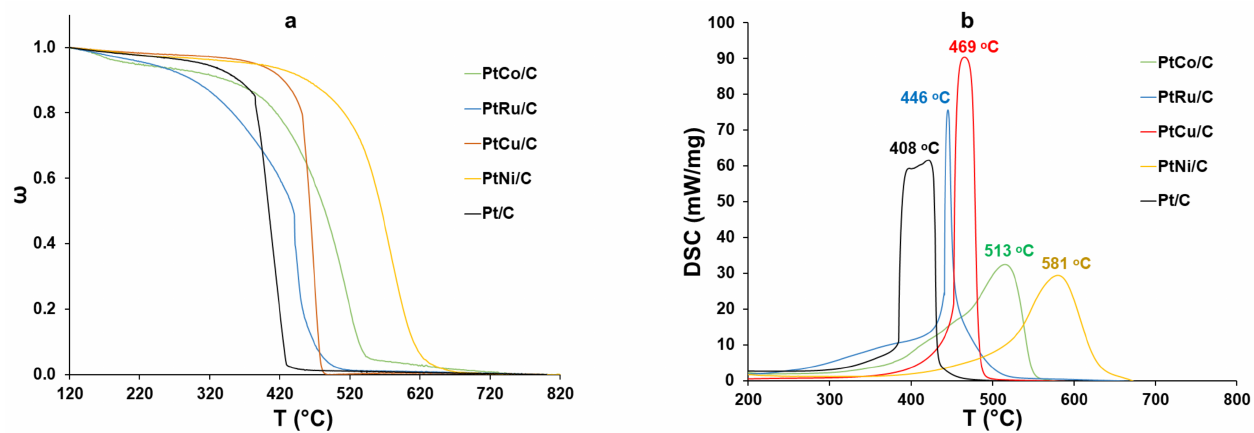
Figure 4. The TGA ( a ) and DSC ( b ) curves of the obtained PtM/C